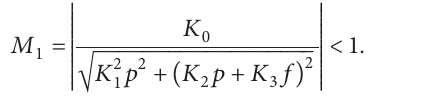
Figure 4: Basins of attraction of the new parametric chemical system (1) showing the effect of p with the parameters of Figure 3 for � √ − 1 ) /2 and Ω � 1: (a) p � 0, (b) p � 0 . 001, and (c) p � 0 . ω � ( 5